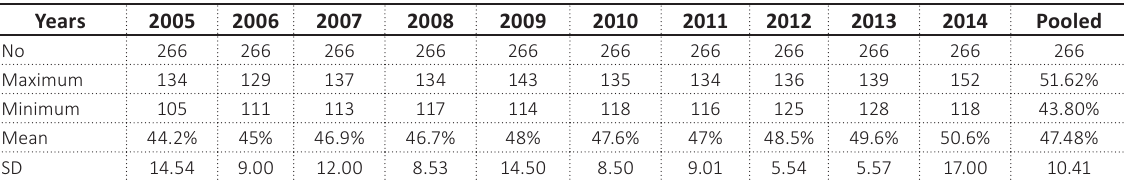
Table 4. Descriptive TVDIS statistics over the ten years